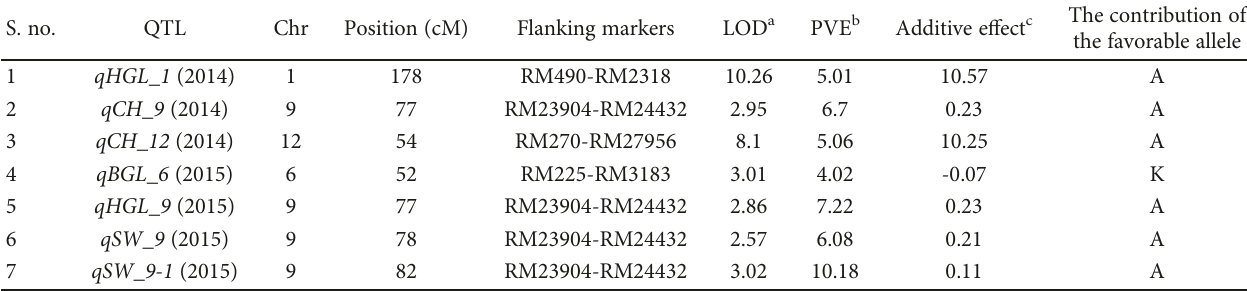
Table 2: Additive e ff ects of QTLs for grain appearance detected by ICIM-ADD in two years. S.